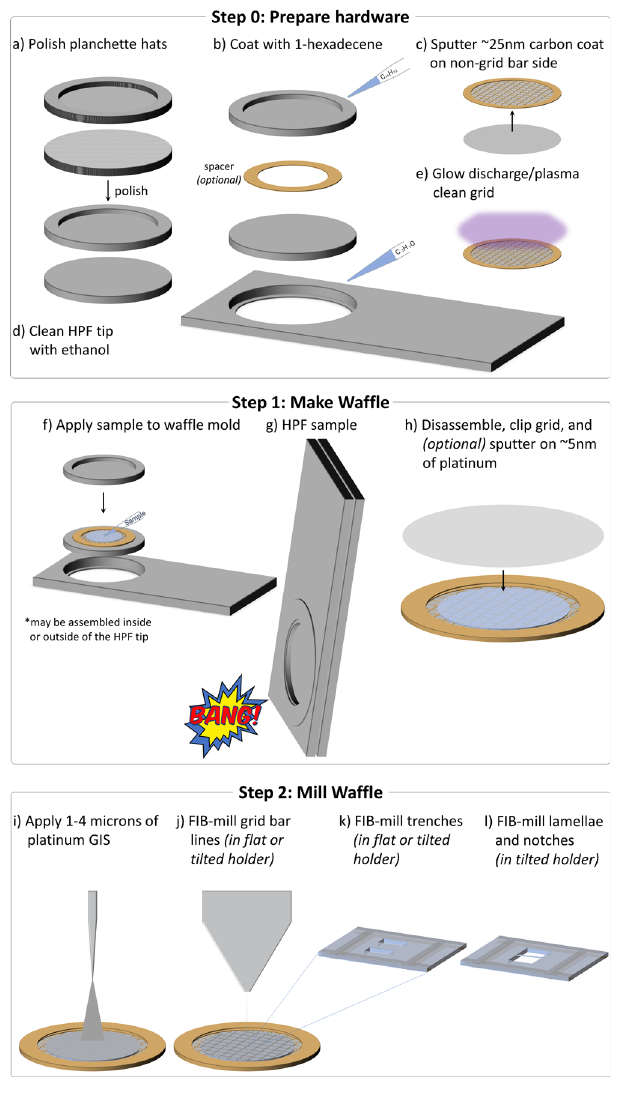
Fig. 1 Schematic of the general work fl ow for creating a waf fl e